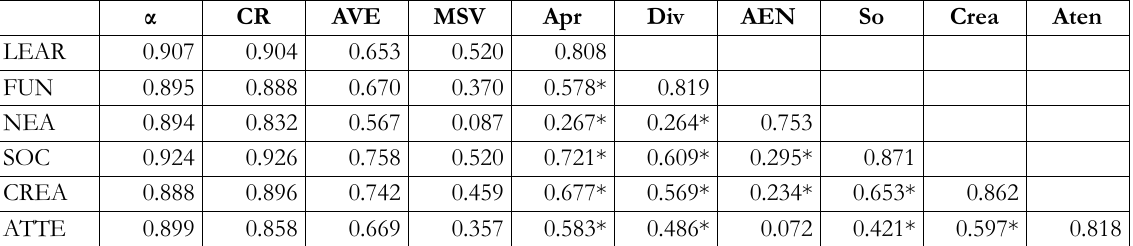
Table 3. Reliability and validity